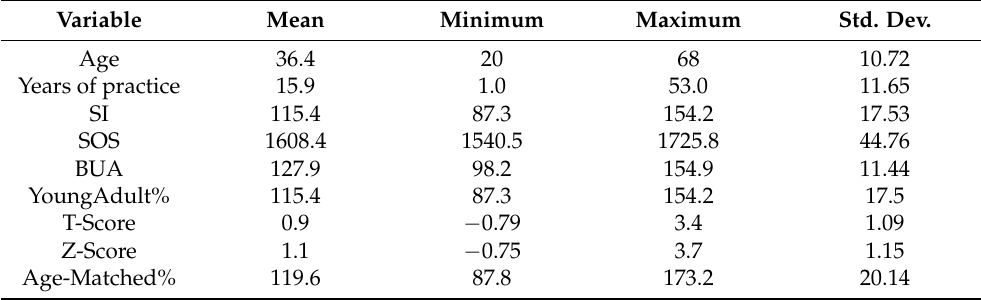
Table 1. Descriptive statistics show the mean values of variables characterizing the